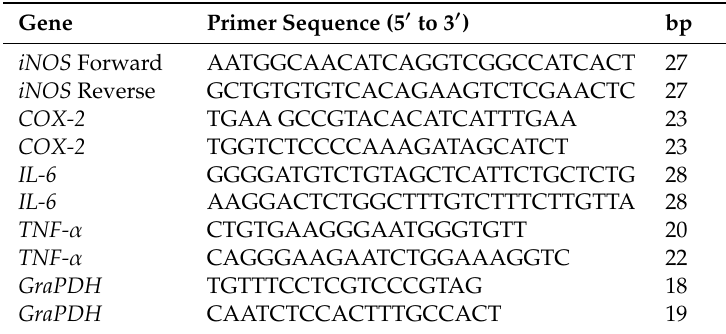
Table 3. Primers used for